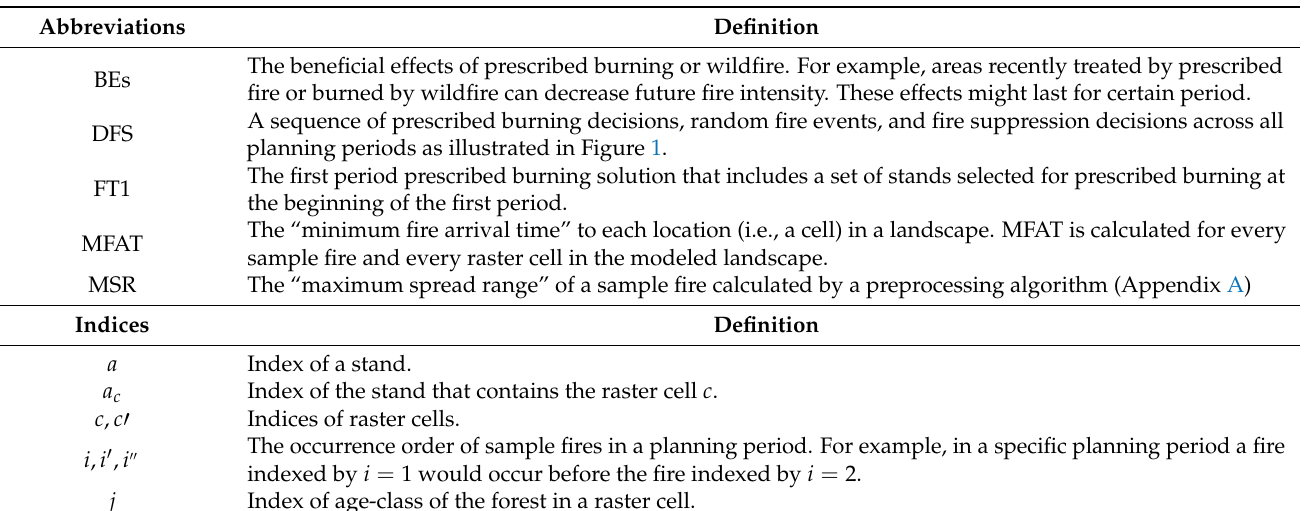
Table A1. Notations of the stochastic program